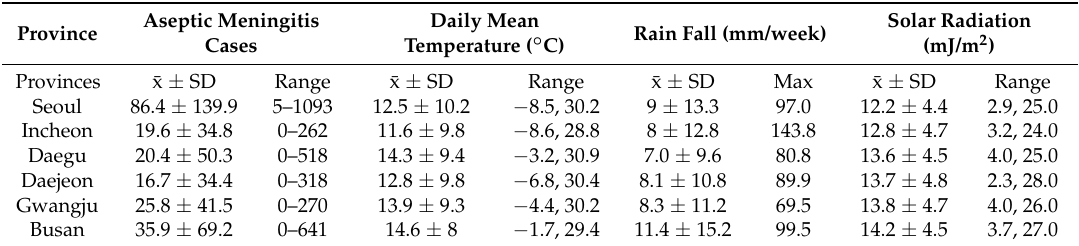
Table 2. Weekly distribution of aseptic meningitis cases and average weather variables from 2002 to 2012 in six metropolitan provinces of Korea. Province